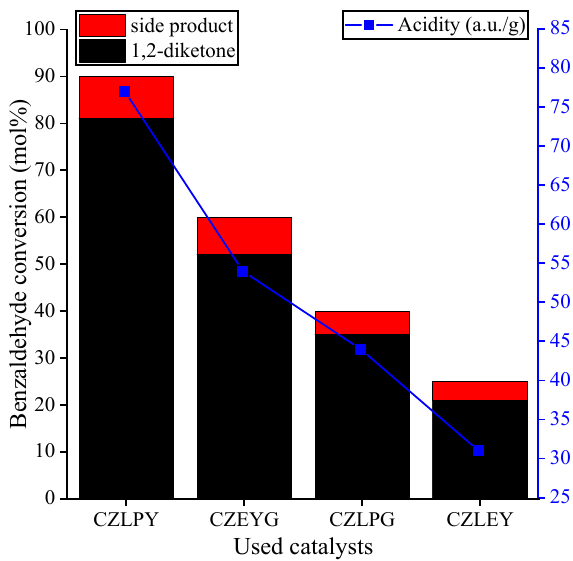
Figure 5. Comparative study of the catalytic ability of the different HEOs to promote the oxidative pinacol-type coupling reaction of the benzaldehyde. Reaction conditions: 1 mmol benzaldehyde, 2 cm 3 acetonitrile, 0.25 mmol benzoic acid, 5 mol% catalyst, reflux temperature, 24 h.